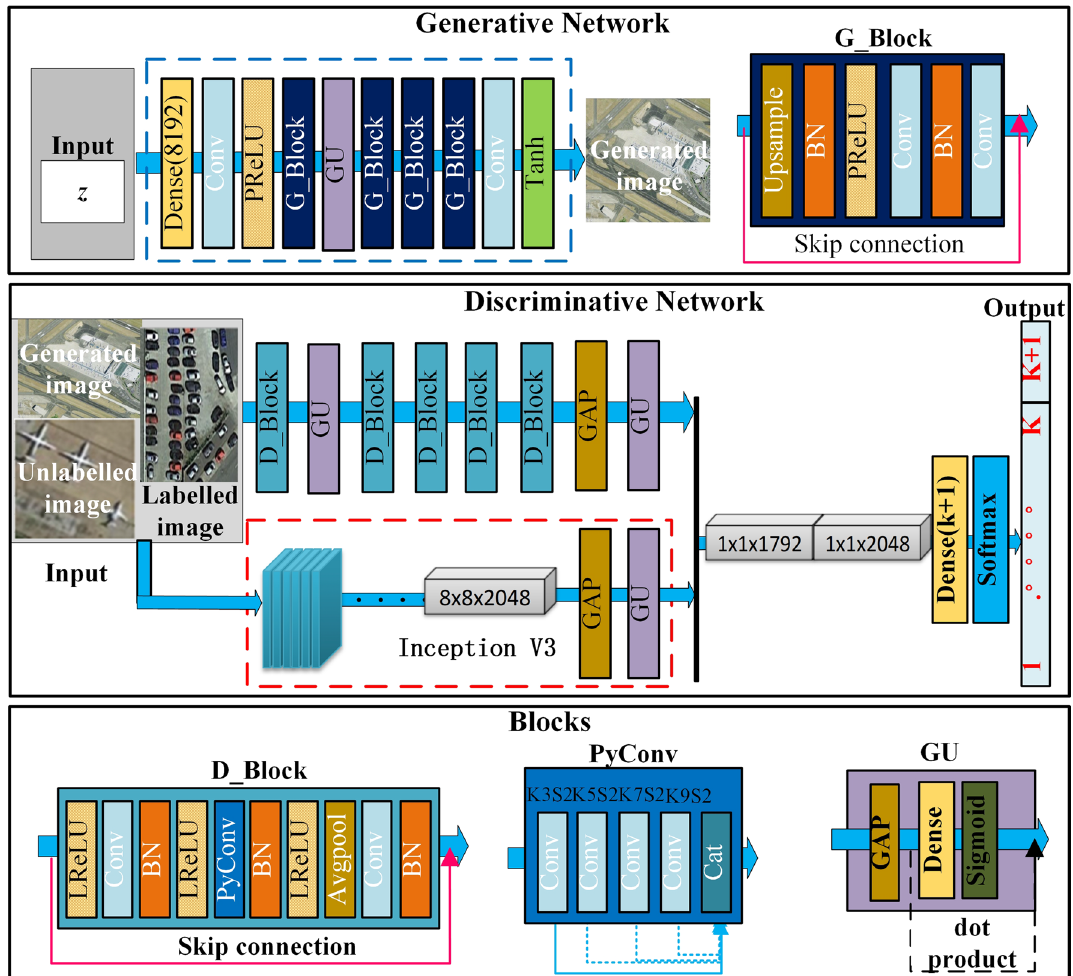
Fig. 2 The framework of the proposed